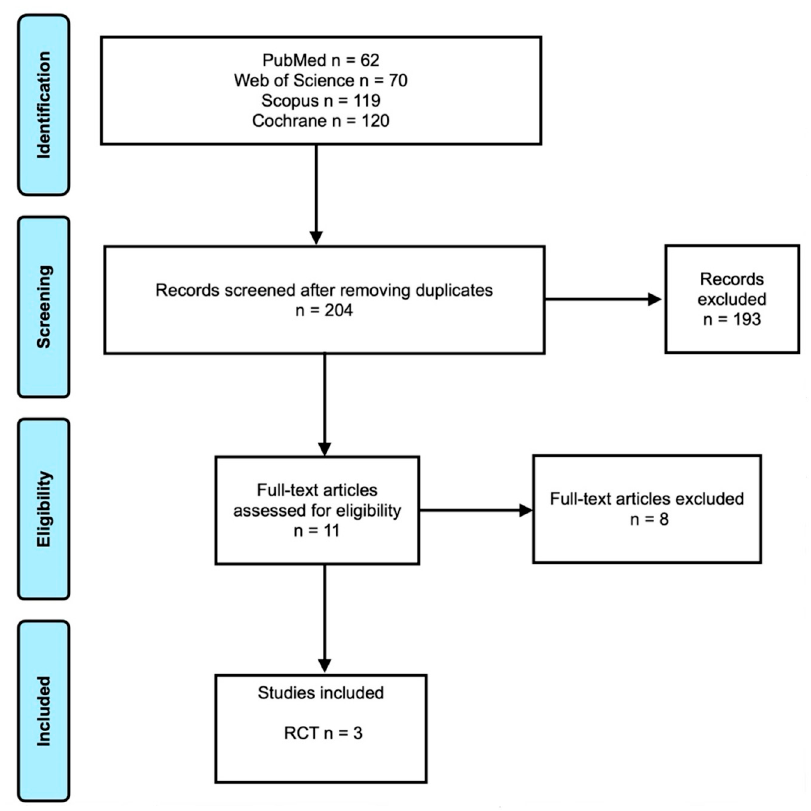
Figure 1. Prisma flowchart.